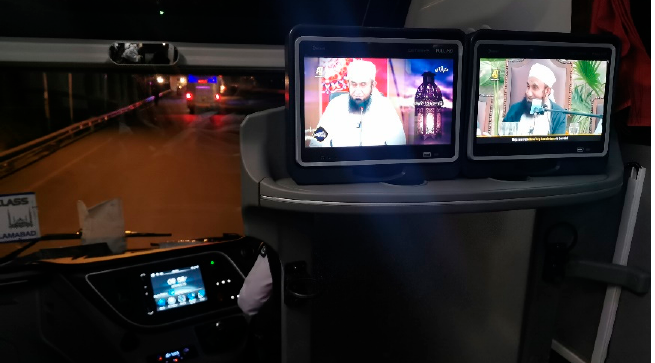
Figure 11. Passengers on a Faisal Movers coach from Islamabad to Lahore watching speeches by Maulana Tariq Jamil via on-board entertainment consoles in April 2022. Source: author’s photo- graph.